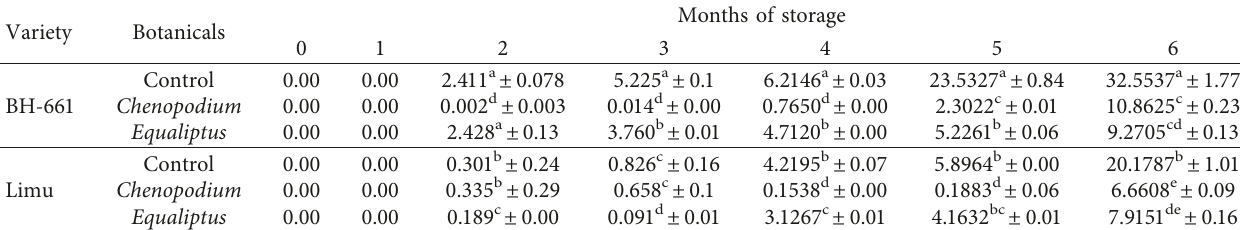
Table 4: Effect of botanicals and variety on percentage weight loss (mean ± SD) of maize. Variety